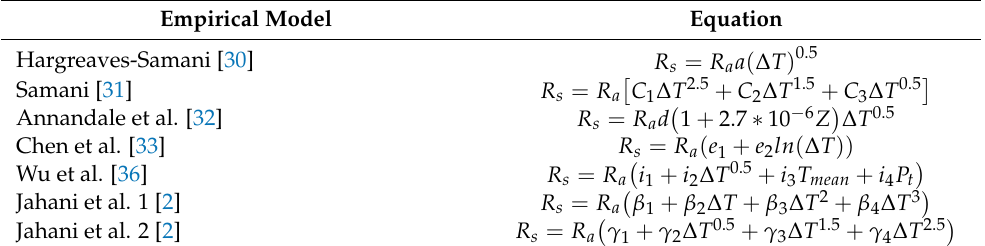
Table 2. Empirical models used for estimating solar radiation.